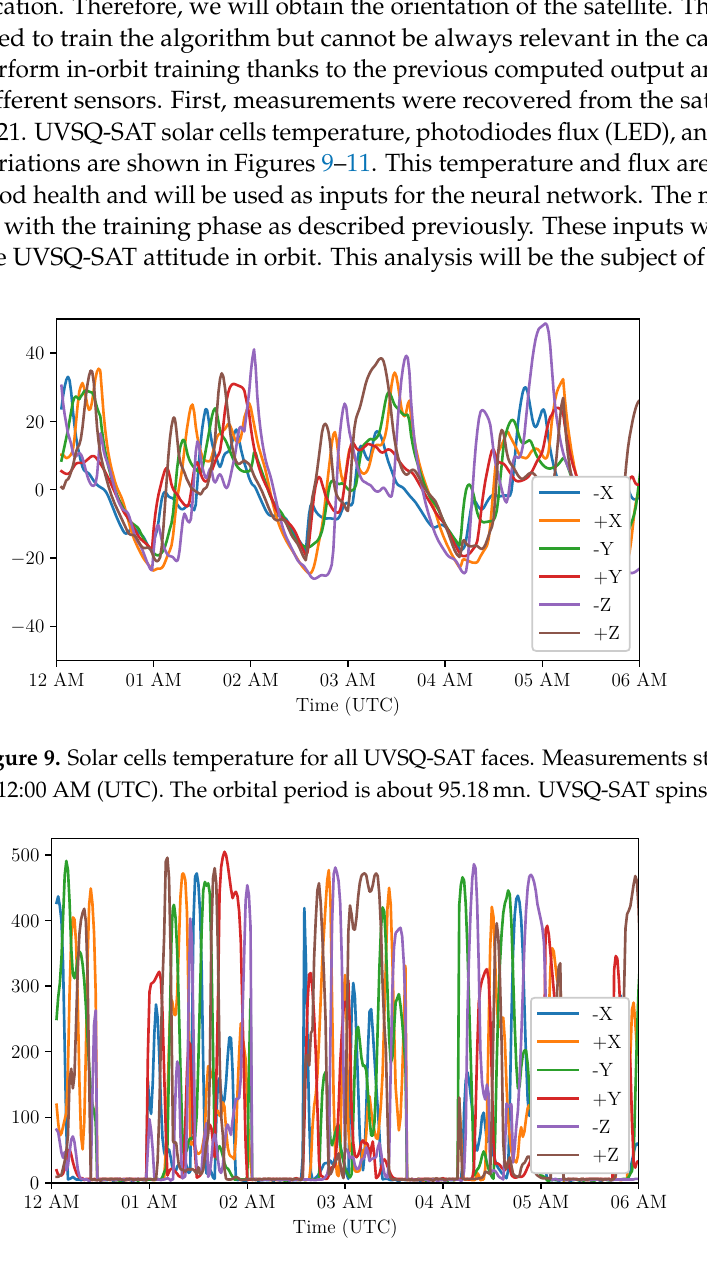
Figure 10. Uncalibrated LED flux (photodiodes in the 400–1100nm wavelength range) for all faces of the UVSQ-SAT CubeSat. Measurements (TSI + OSR) start from 7 February 2021 at 12:00 AM